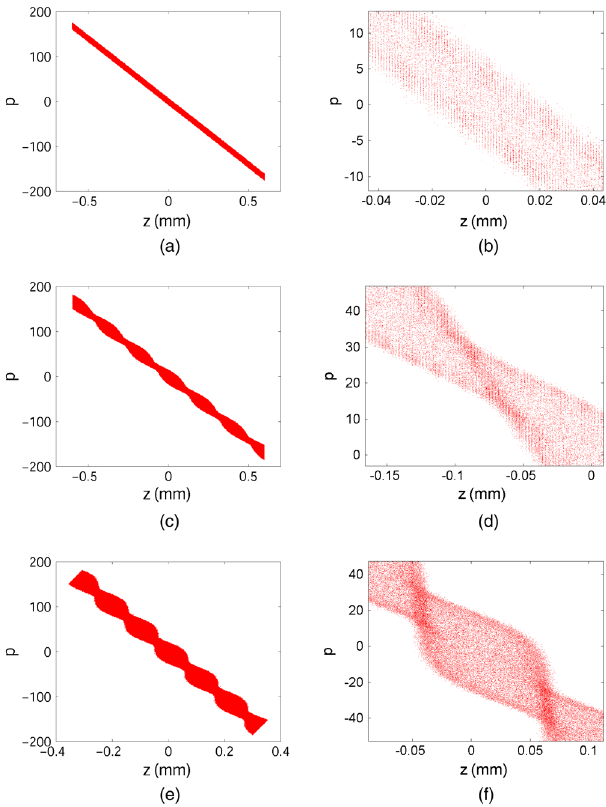
FIG. 5. Phase space evolution of the electron beam with linear energy chirp at various locations, where p is the dimensionless energy derivation in Eq. (2). (a) Exit of modulator 1; (b) exit of modulator 1, closer look; (c) exit of modulator 2; (d) exit of modulator 2, closer look; (e) exit of dispersion 2; and (f) exit of dispersion 2, closer look.